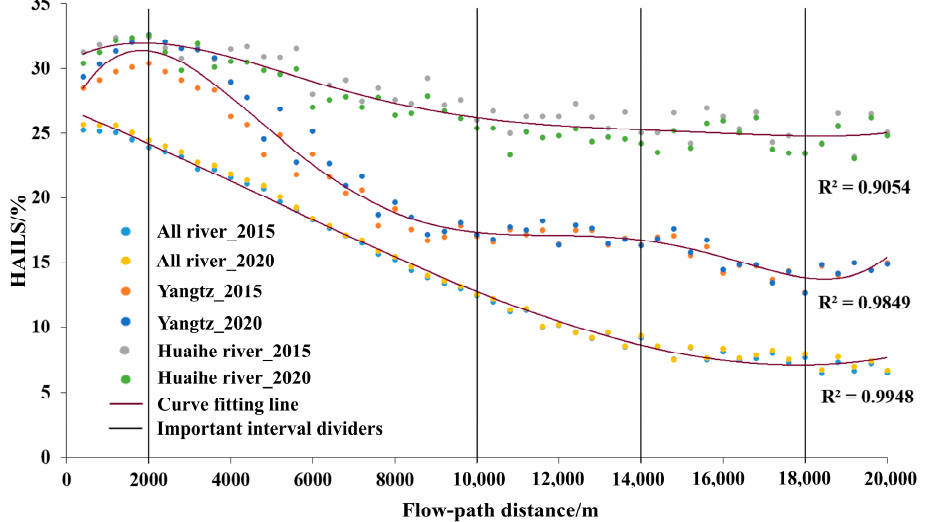
Figure 4. HAILS variation along the flow ‐ path distances in 2015 and 2020.